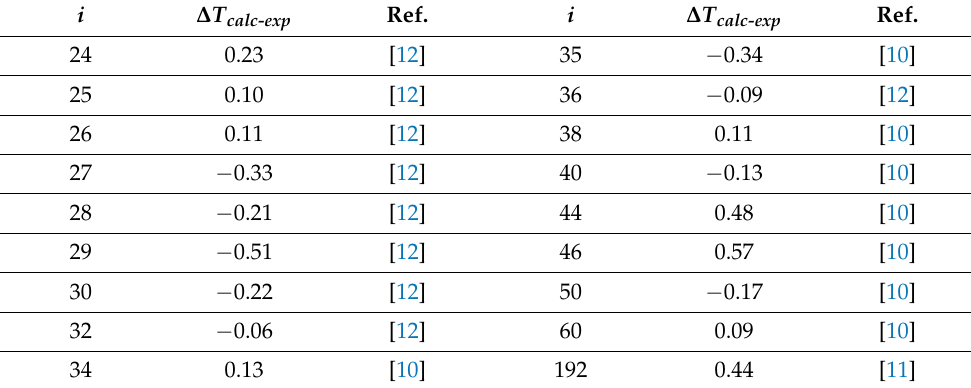
Table 1. Difference ∆ T calc-exp K between melting points T m,calc calculated with Equation (6) and available experimental values T m,exp for n-alkanes with i > 23 carbon